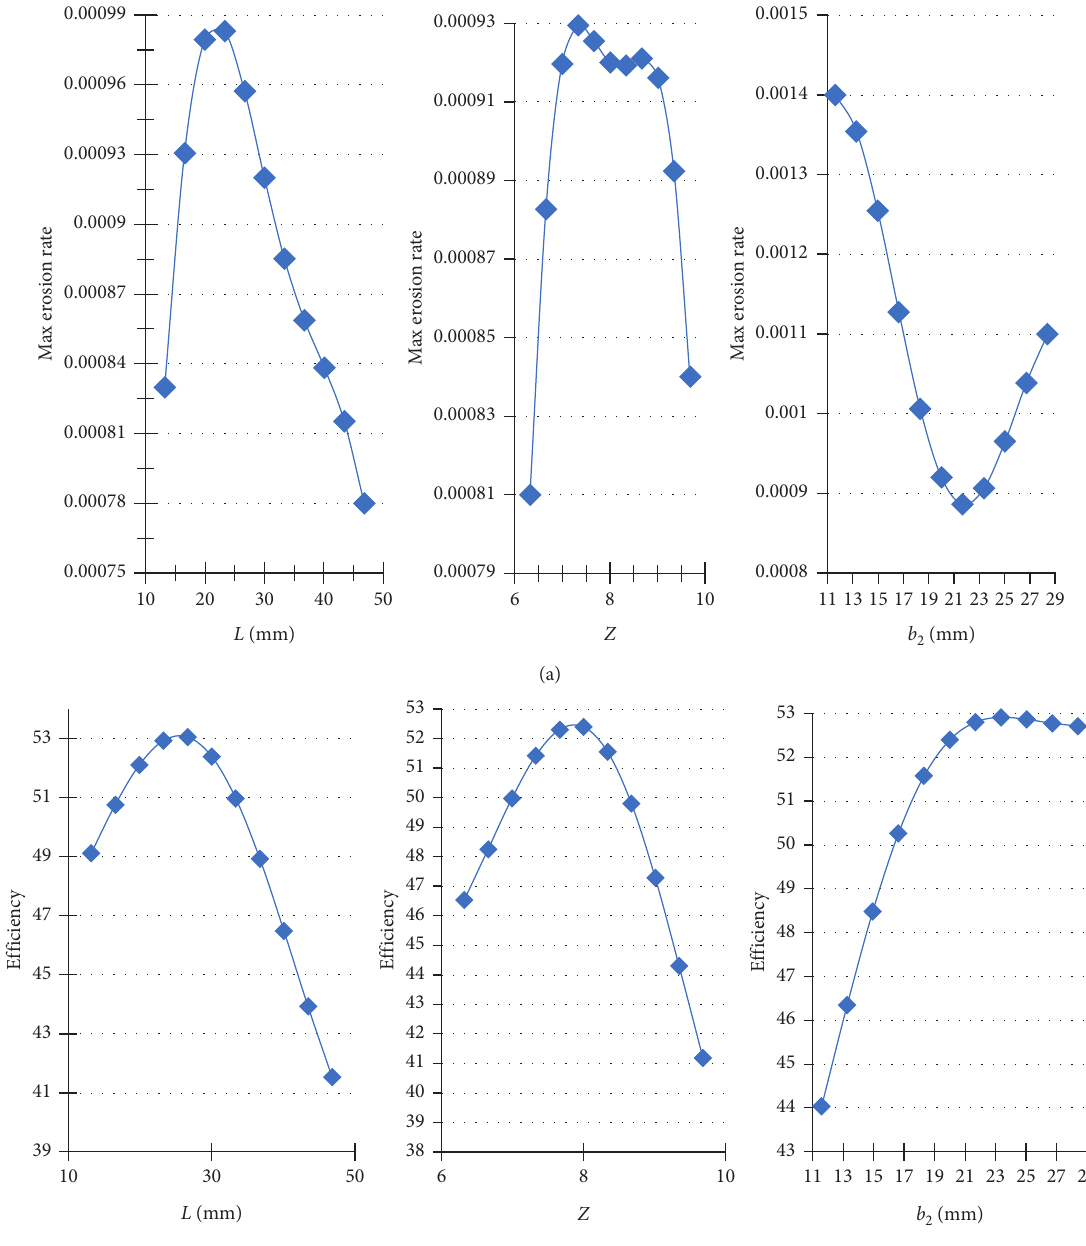
Figure 7: Relationship between objects and factors ( L � 30mm, b